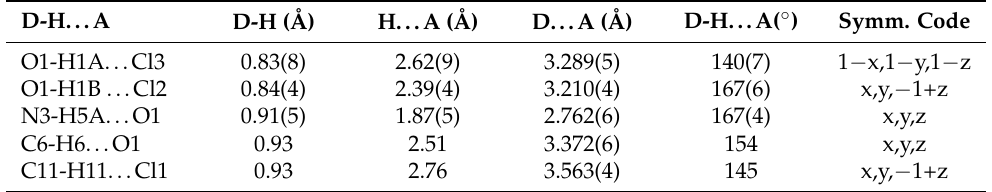
Table 3. The hydrogen bond parameters in 1 .